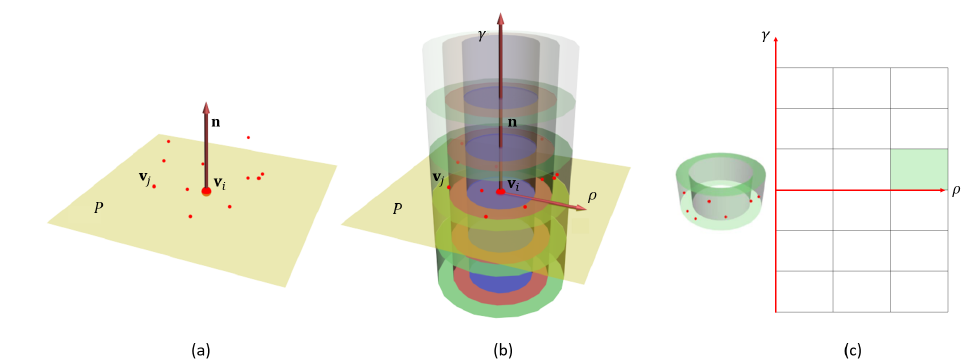
Figure 1. SI representation for a reference oriented point ( v i , n ): ( a ) 3D point cloud and an imaginary plane P containing v i and having the normal, n ; ( b ) the 3D space around v i is partitioned into non-overlapping subspaces; and ( c ) the 2D histogram of the spin image with axes ρ and γ